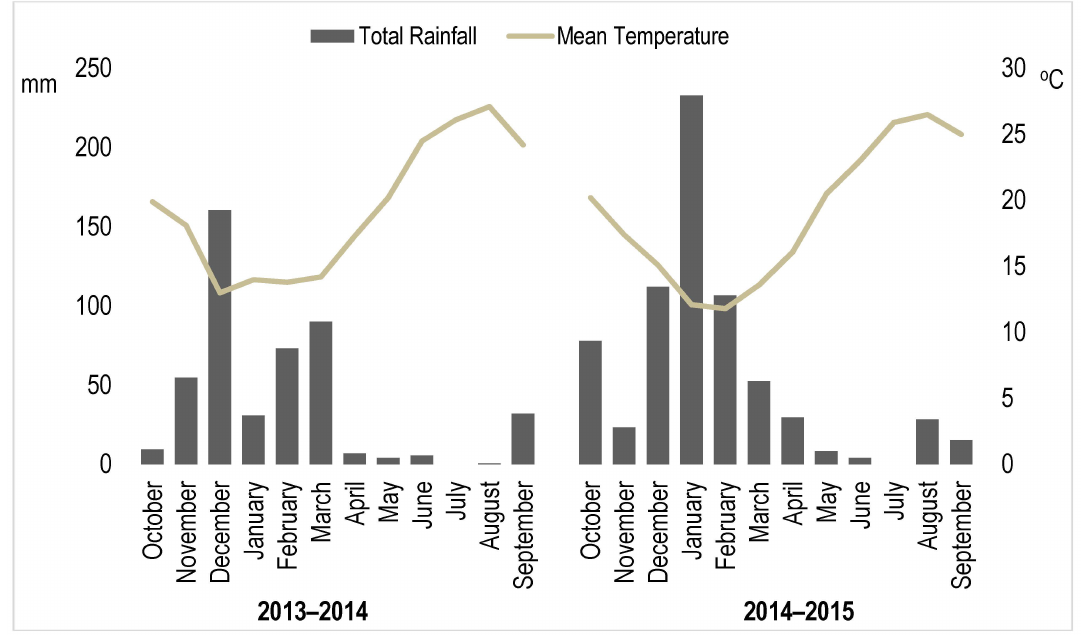
Figure 1. Total monthly precipitation and mean air temperature ( ◦ C) in the 2013/2014 and 2015/2016 growing seasons. Data from Knossos weather station, Heraklion prefecture, Crete, Greece (elevation: 115 m; latitude: 35 ◦ 18 (cid:48) 00 (cid:48)(cid:48) north (N); longitude: 25 ◦ 12 (cid:48) 00 (cid:48)(cid:48) east (E); https://stratus.meteo.noa.gr/front accessed on 1 December